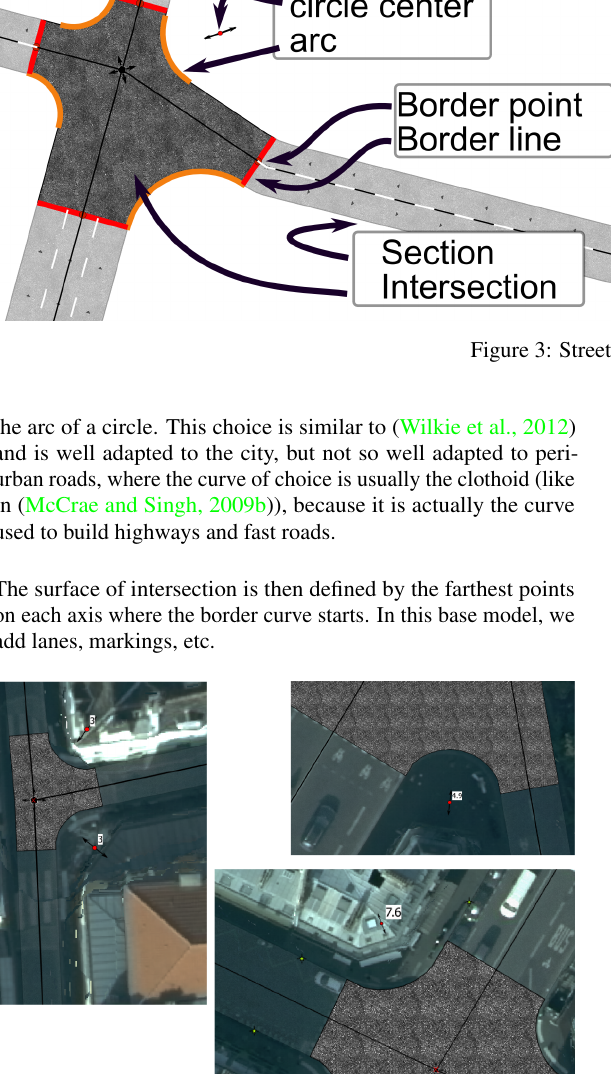
Figure 4: 3 different radius size (3m, 4.9m, 7.6 m) for streets of various importancy, from real Paris data